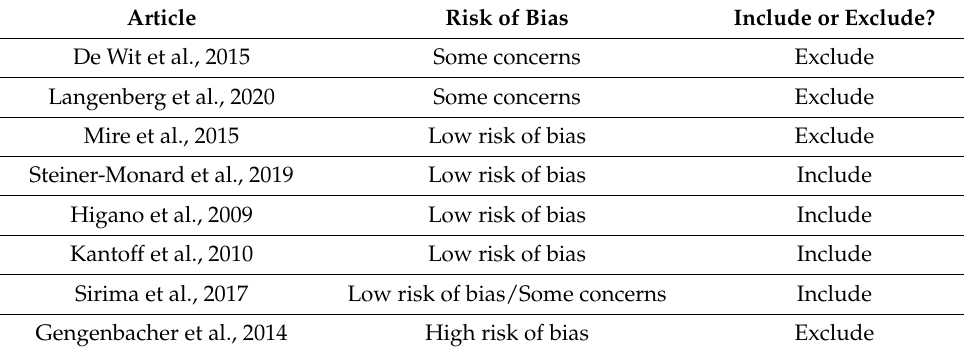
Table 1. RCTs and Risk of Bias using the Cochrane Risk of Bias